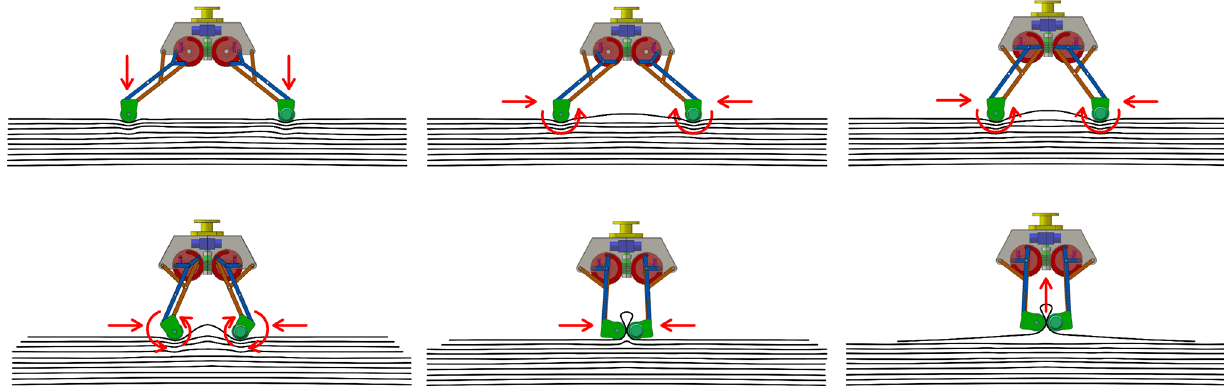
Figure 9. Diagram of the multi-layer tiled grabbing process.